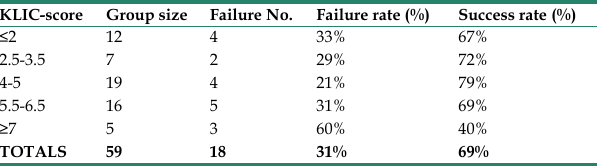
Table 2: KLIC-score result and treatment outcomes KLIC-score Group size Failure No. Failure rate